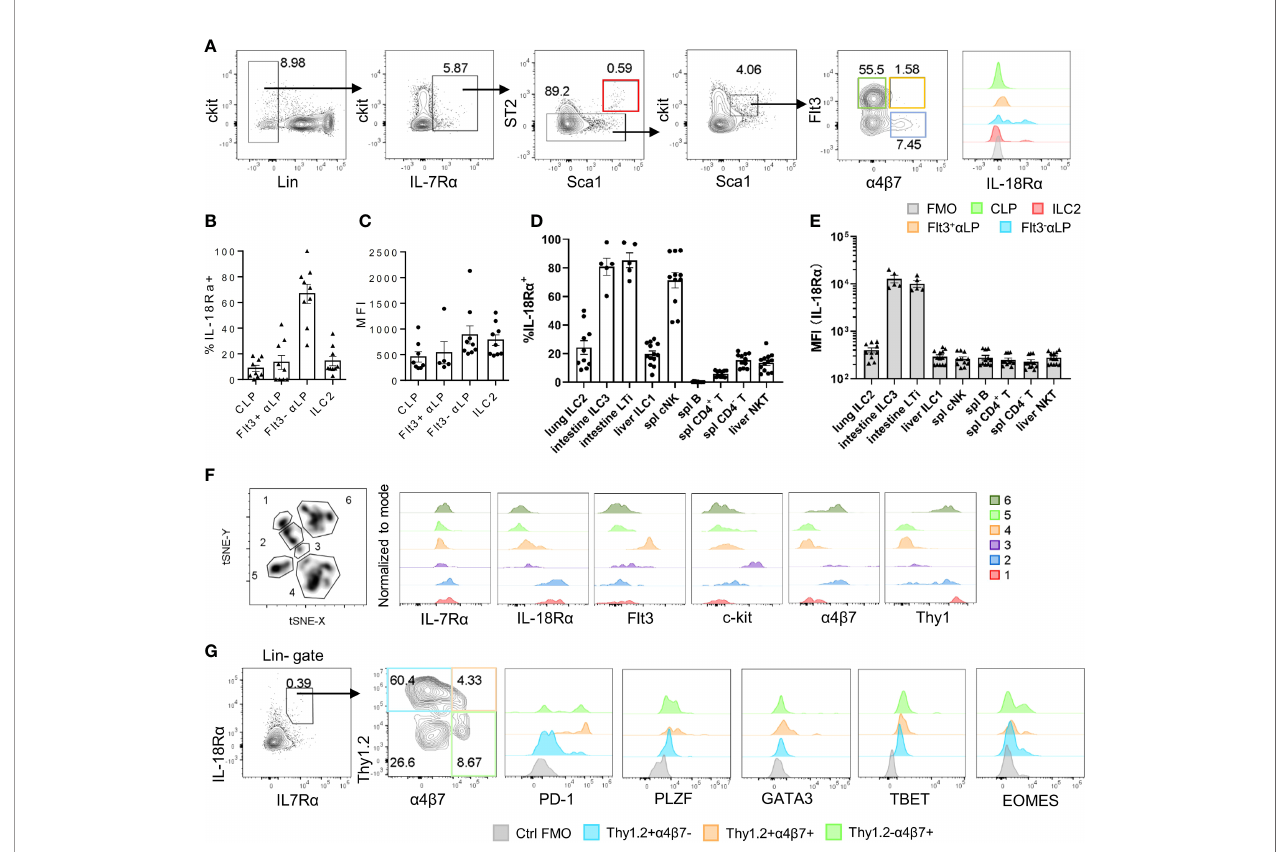
FIGURE 1 | IL-18R a is expressed on BM ILC progenitors. (A) The expression of IL-18R a on BM progenitors of wild-type C57BL/6J mice was analyzed by fl ow cytometry. CLP, Flt3 + a LP, Flt3 - a LP, and ILC2 were de fi ned as follows respectively: lin - IL-7R a + ckit int Sca1 int ST2 - Flt3 + a 4 b 7 - , lin - IL-7R a + ckit int Sca1 int ST2 - Flt3 + a 4 b 7 + , lin - IL-7R a + ckit int Sca1 int ST2 - Flt3 - a 4 b 7 + , lin - IL-7R a + Sca1 + ST2 + . (B) Percentage of IL-18R a + cells in the progenitors in panel (A, C) Mean fl uorescence intensity of IL- 18R a in IL-18R a + cells from CLP, Flt3 + a LP, Flt3 - a LP, and ILC2 in panel (A)(D) Percentage of IL-18R a + lymphocytes in peripheral tissues. (E) Mean fl uorescence intensity of IL-18R a in lymphocytes in peripheral tissues. (F) t-SNE analysis of lin-IL-7R a + cells in the BM, and expression of IL-7R a , IL-18R a , Flt3, ckit, a 4 b 7, and Thy1 in 6 clusters. (G) Representative FACS plot showing the expression of progenitor and ILC-related markers in Thy1 + a 4 b 7 - , Thy1 + a 4 b 7 + , and Thy1 - a 4 b 7 + in BM IL-7R a + IL-18R a + cells. Data are representative of more than three independent experiments with three mice in each group in panels (B – E) . The data are presented as mean ± SEM in panels (B – E) . Data are representative of three mice in panel (G)